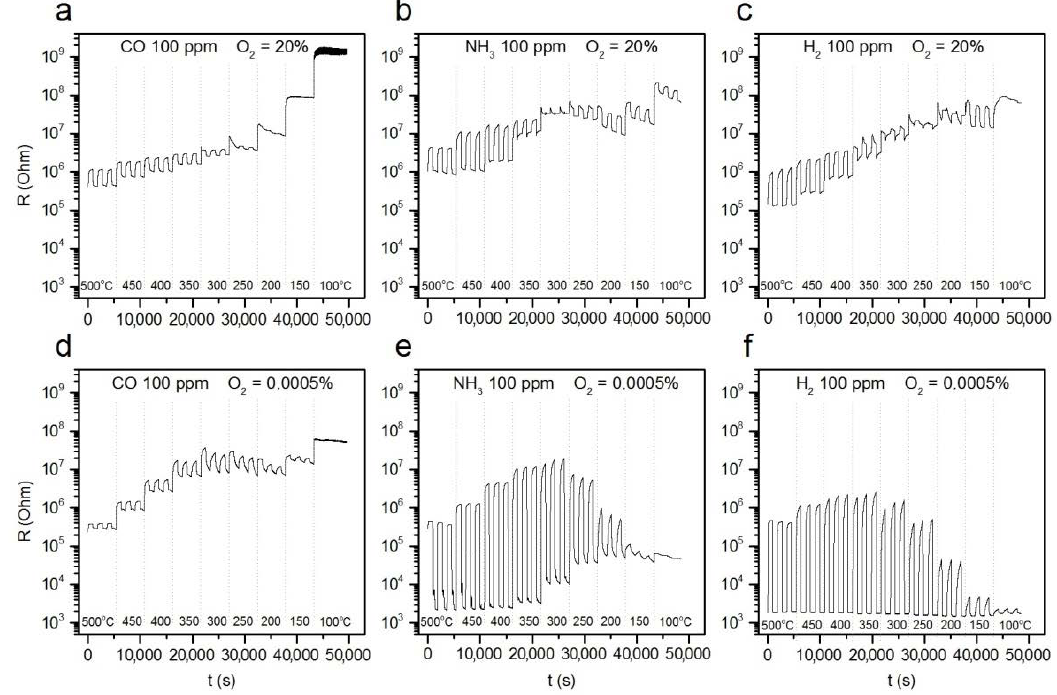
Figure 3. Transient sensor response of ZnO/Pd nanofibers to 100 ppm of reducing gases CO ( a , d ), NH 3 ( b , e ) and H 2 ( c , f ) in dry atmosphere (relative humidity at 25 °C RH = 0%) with different oxygen backgrounds of 20% ( a – c ) and 0.0005% ( d – f ) in the temperature range 100–500 °C.